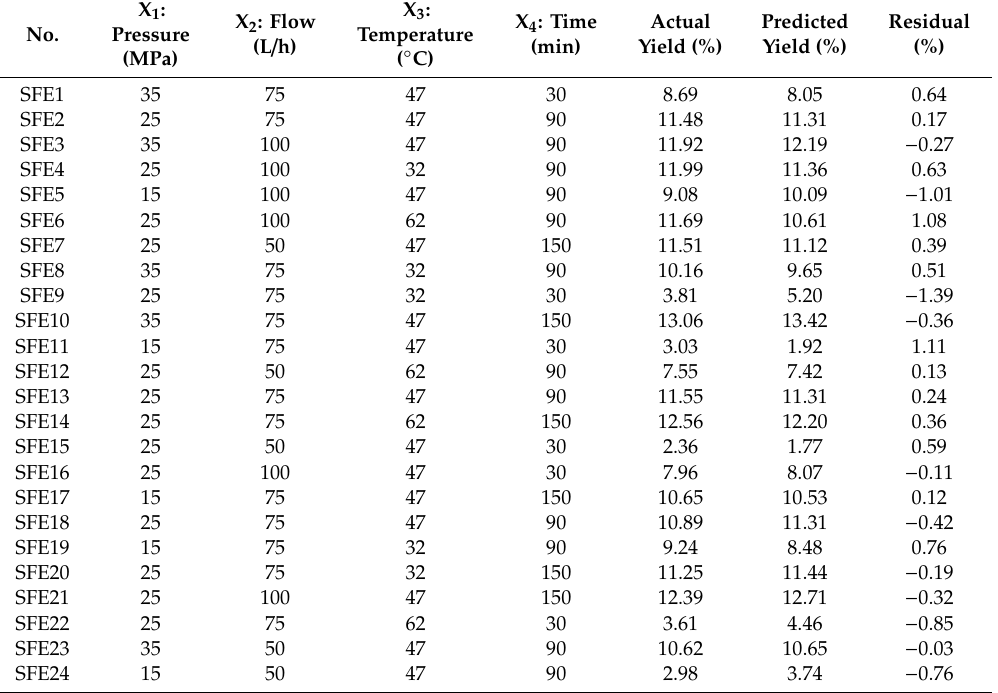
Table 1. The experimental conditions of CO 2 supercritical fluid extraction (CO 2 -SFE) and yield of